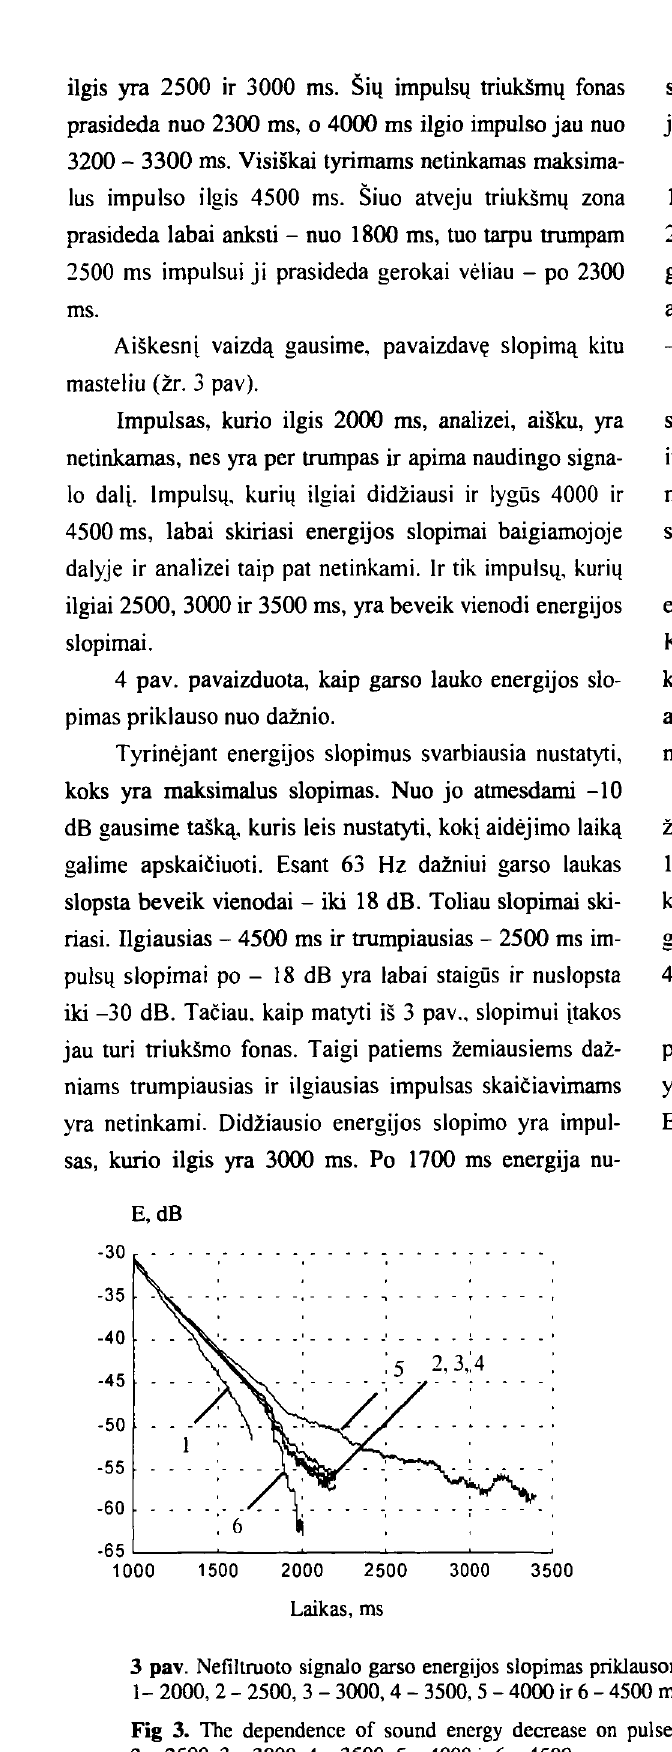
3 pav. Nefiltruoto signalo garso energijos slopimas prik.lausomai nuo impulso ilgio. Sakje yra tik 170 kedzi4. Fig 3. The dependence of sound energy decrease on pulse length. Only 170 chairs in the hall. 1-